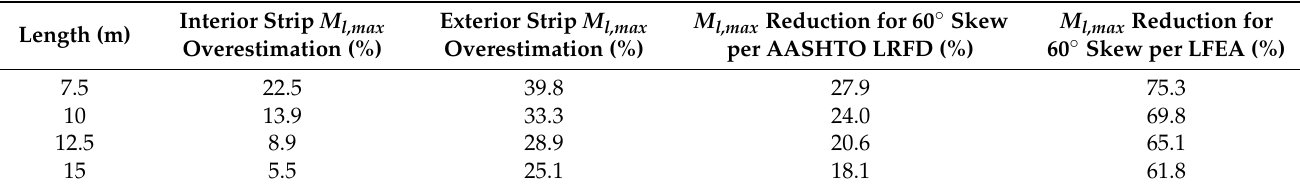
Table 3. Interior and exterior strip M l,max overestimation and M l,max reduction (in percentage) using AASHTO LRFD and LFEA.